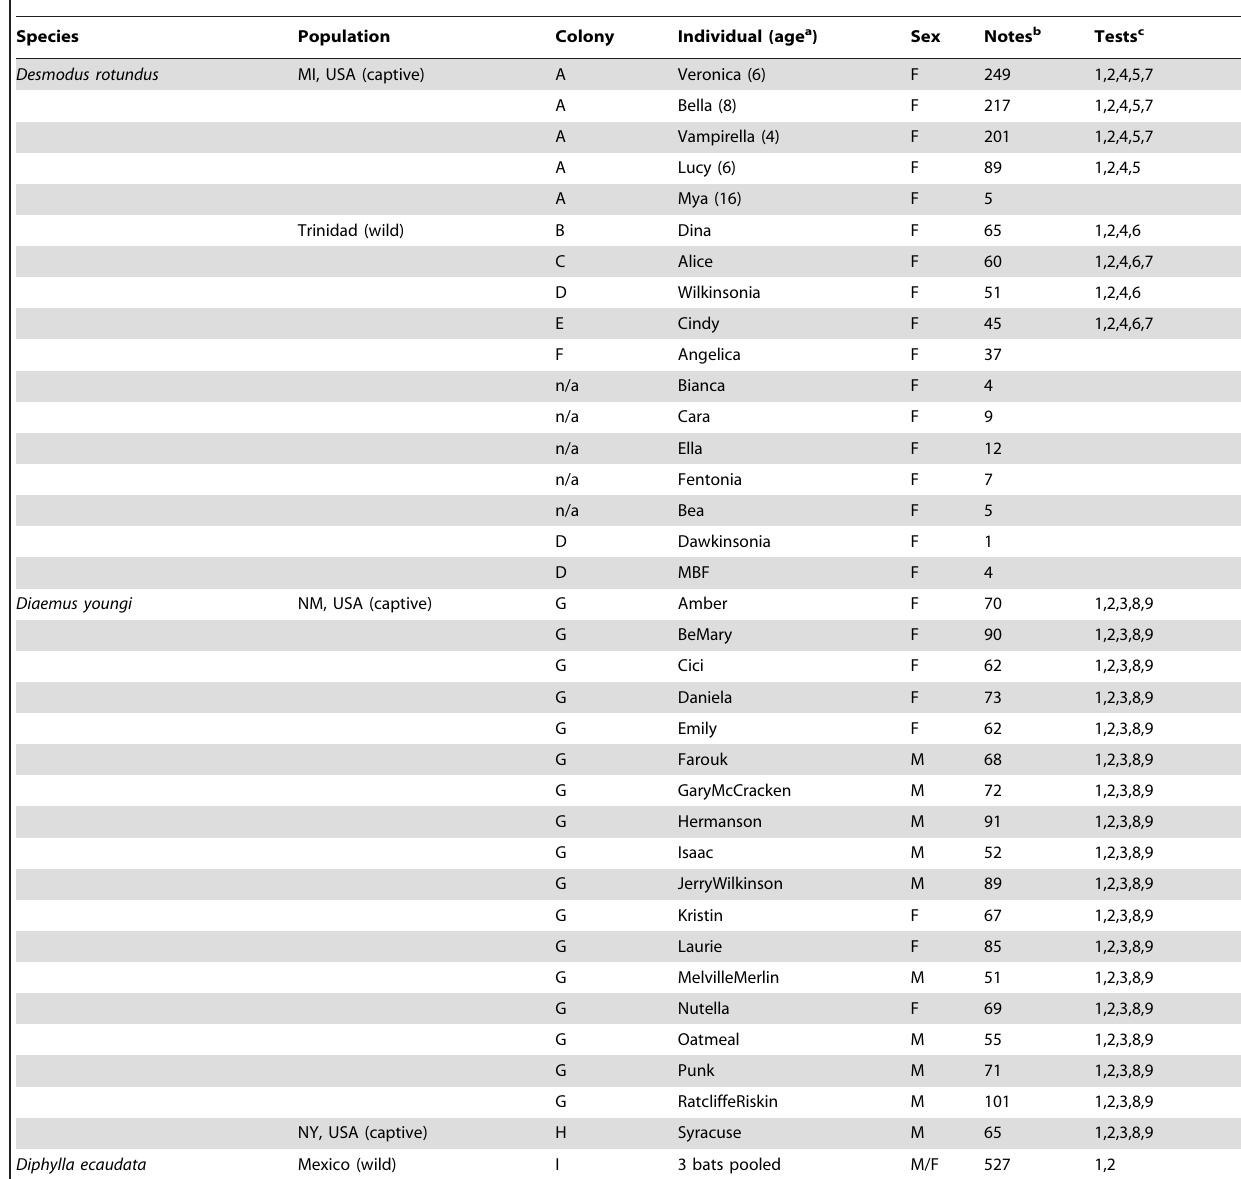
Table 1. Vampire bats used for species-typical descriptions and information estimates.